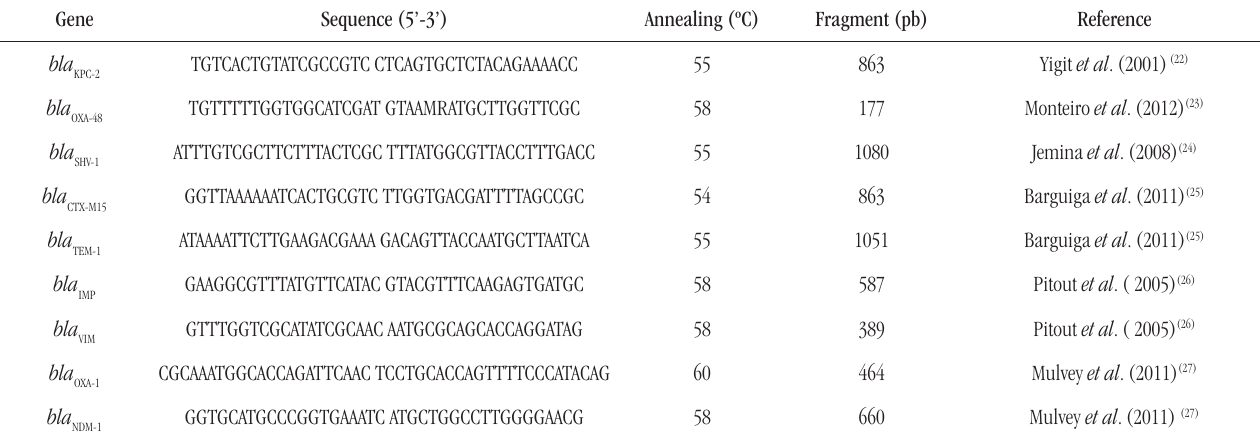
taBLE 1 − Detection of beta-lactamase genes by